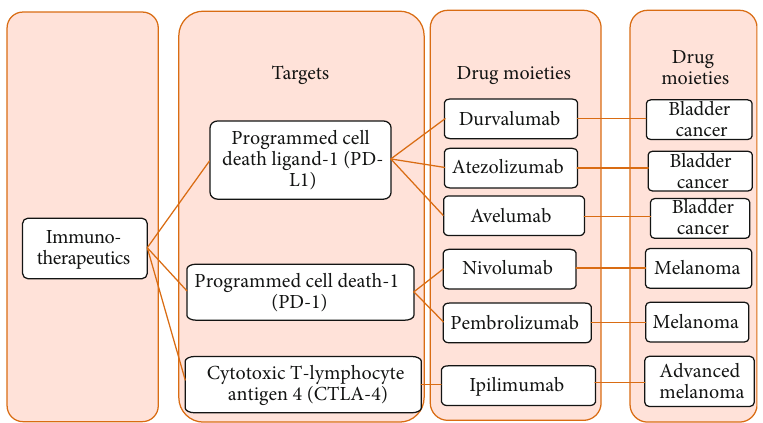
Figure 1: Examples of immunotherapeutics (mainly monoclonal antibodies) approved by the FDA for cancer